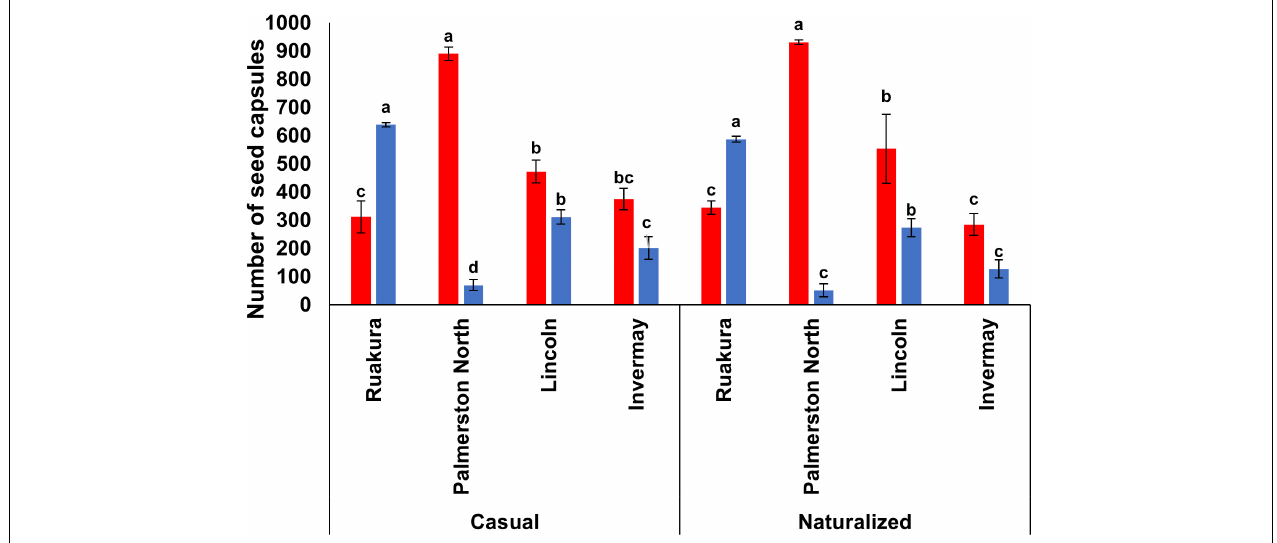
FIGURE 8 | The number of seed capsules for the casual and naturalized populations of A. theophrasti in five different regions of New Zealand in the first (red bars) and second (blue bars) experiments. No seed capsules were developed by plants in Woodlands in both experiments (in the second experiment, plants in Woodlands died after emergence). For each population, vertical bars of the same colour with different letters are significantly different at 5% probability. The error bars represent ± standard error of the